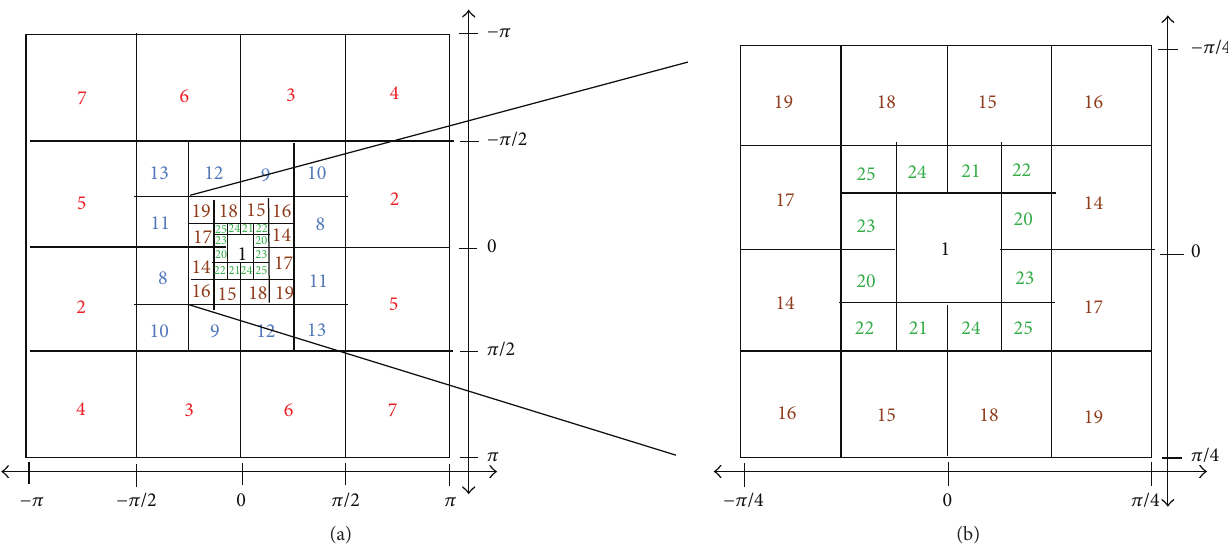
Figure 5: Four-scale filterbank [22]. (a) Complete frequency range of the filterbank. (b) Zoom on the low frequency filters (to be easily readable).